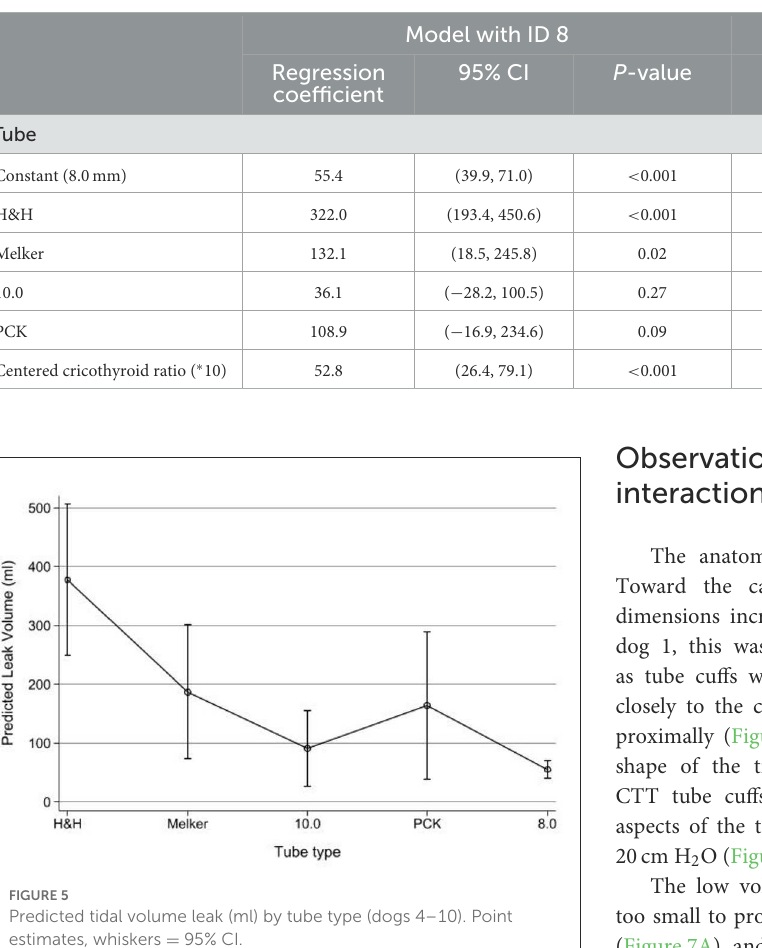
mean leak volumes were recorded for the 8.0 mm tube with 55.4 ml (95% CI: 39.9–71.0) and 10.0 tube with 91.6ml (95%